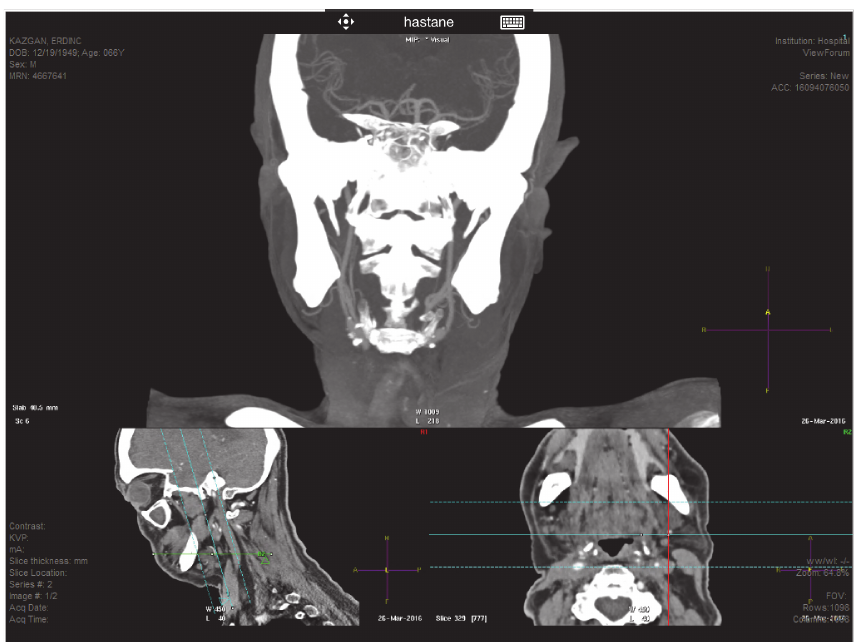
Figure2:Coronalobliquereformattedcomputedtomographyangiographicimagethroughtheneckshowsocclusionofbothcommoncarotid arteries. Both internal and external carotid arteries are patent, however, filling via collateral flow. Intracranial carotid circulation and posterior circulation are